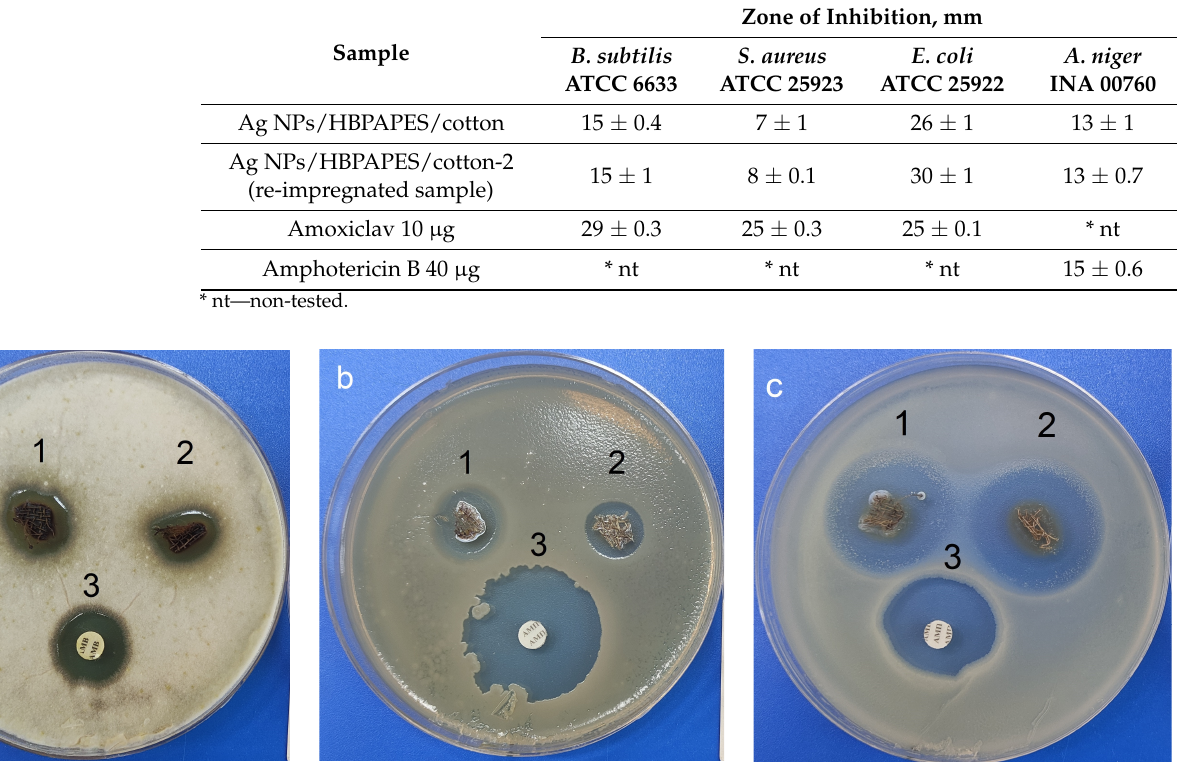
Table 1. Antimicrobial activity of Ag NPs/HBPAPES/cotton and Ag NPs/HBPAPES/cotton-2.